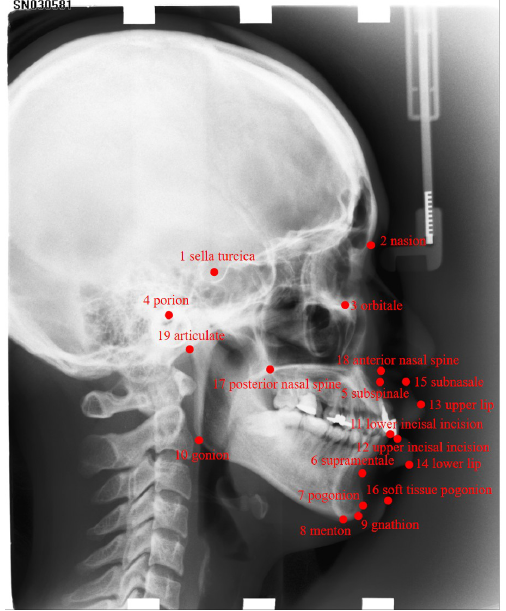
Figure 1. All 19 landmarks on x-ray images which we aim to detect.